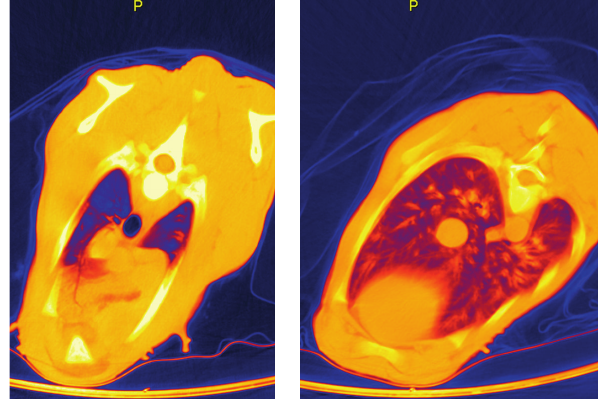
Figure 3: CT: thorax layer in false-color representation of a subject of group A at 12 hours p. n.